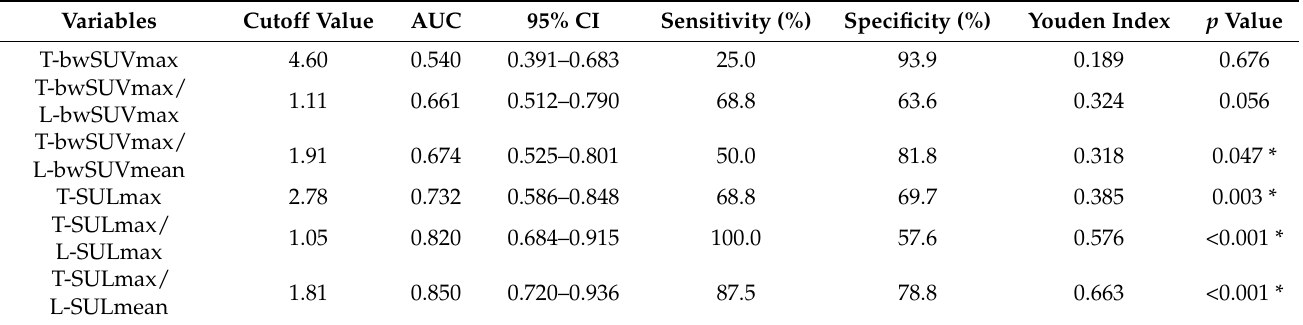
Table 4. Receiver-operating characteristic curve analysis of 18 F-fluorodeoxyglucose positron emission tomography/computed tomography metabolic parameters for prediction of recurrence.